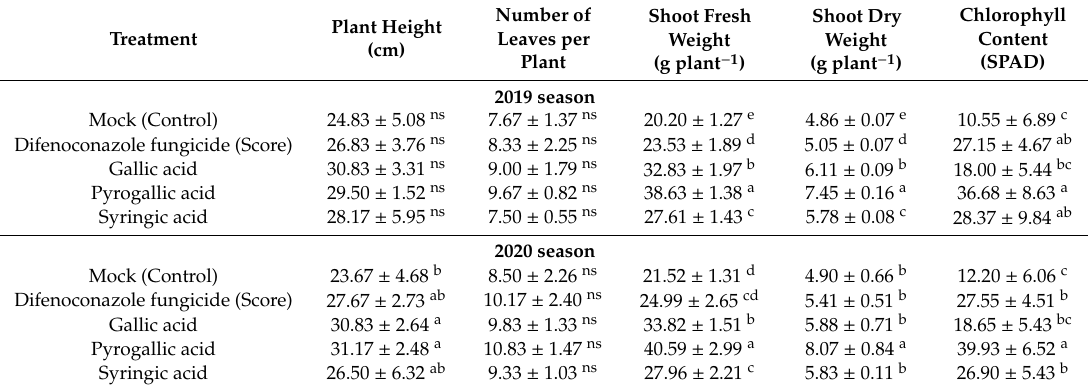
Table 2. E ff ects of gallic acid and its derivatives on the growth parameters and chlorophyll content of tomato plants (Super strain B–F 1 hybrid) infected with A. solani under greenhouse conditions during 2019 and 2020 seasons ( n =